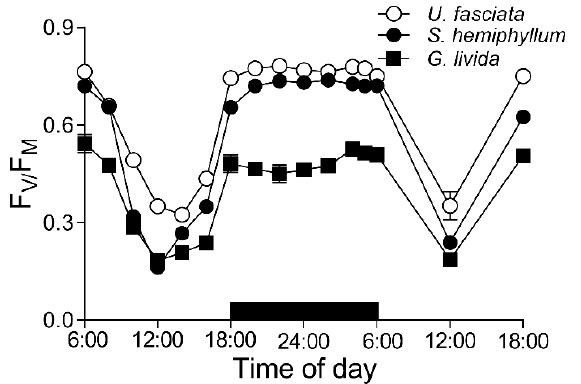
Figure 2. Daily changes of the maximal PS II photochemical quantum yield (F V /F M ) of U. fasciata , S. hemiphyllum and G. livida in field condition. Points show averages of measurements on three inde- pendent macroalga thalli, and error bars show the standard deviations ( n = 3), often within symbols.